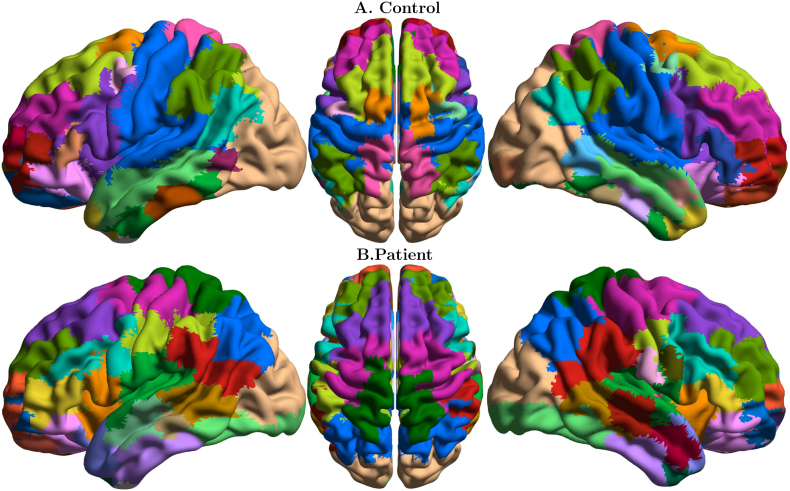
Functional connectivity modules obtained by Asymptotical Surprise overlaid on an anatomical template for: A. healthy controls; B. schizophrenia patients; colors were assigned independently in the two groups to maximize contrast between adjacent modules.